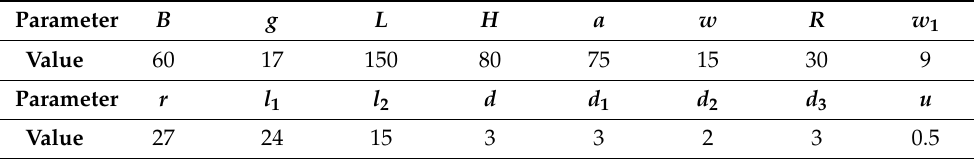
Table 1. Structural parameters of single ‐ legged arthropod robot (mm).